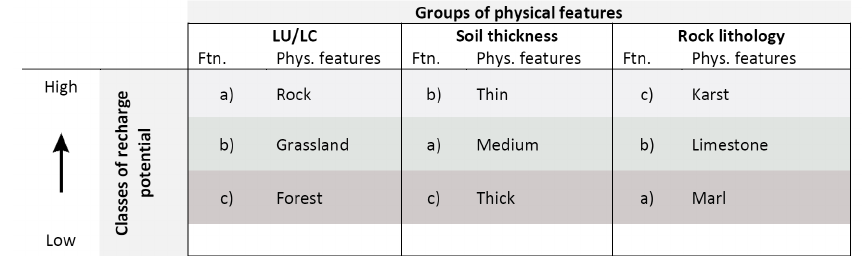
Table 2. Schematic conceptual basin classification